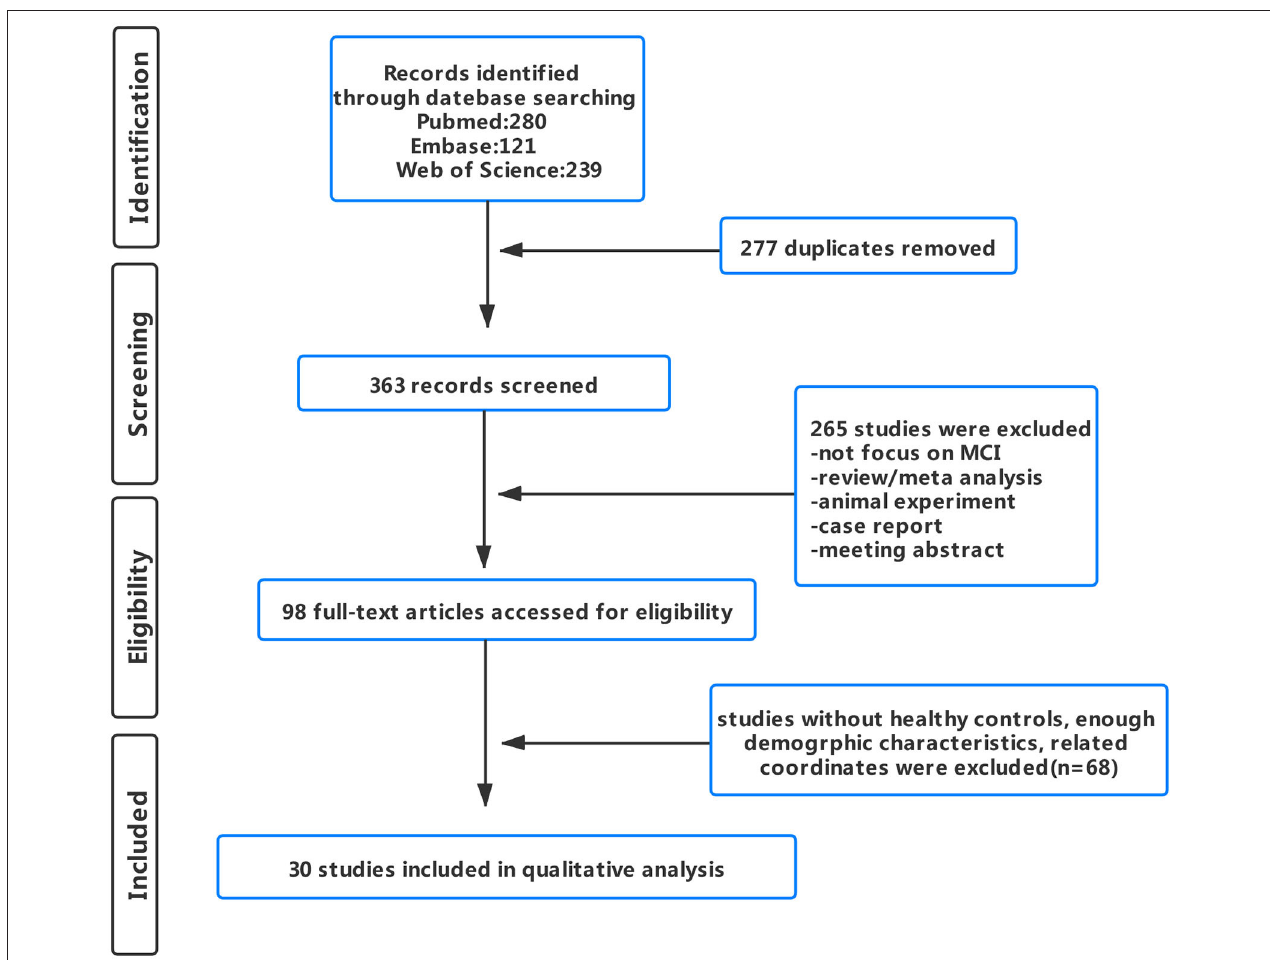
FIGURE 1 | Flowchart shows study selection process.